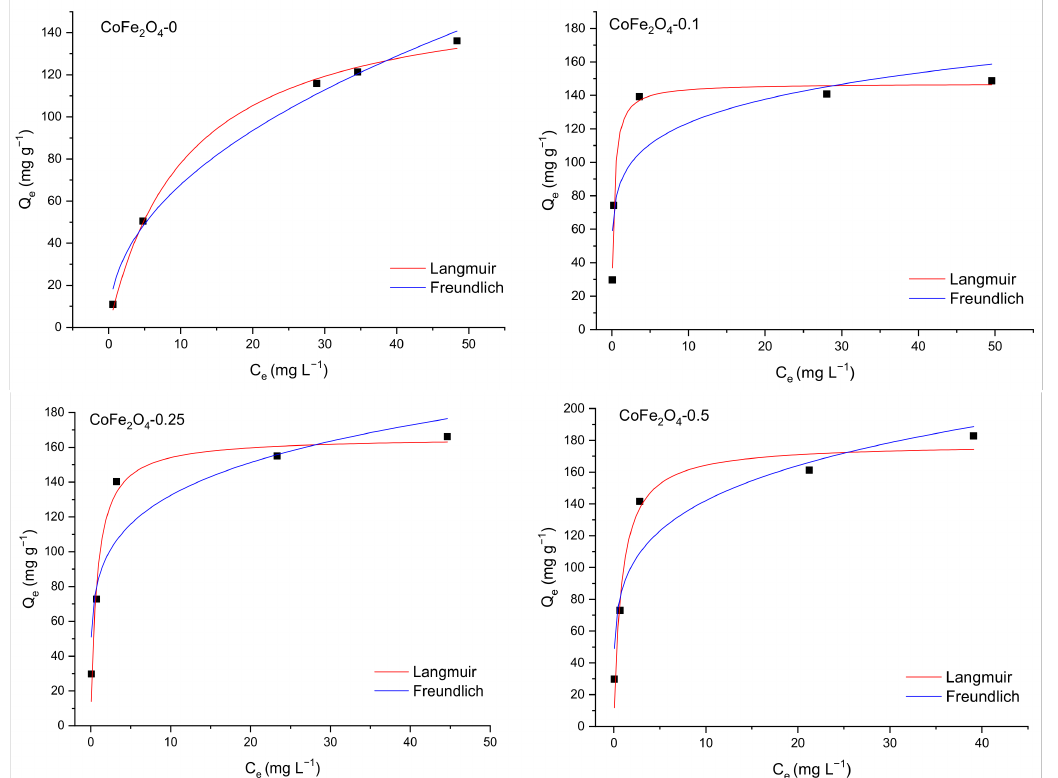
Figure 19. Langmuir and Freundlich fitting curves for CR adsorption onto CoFe 2 O 4